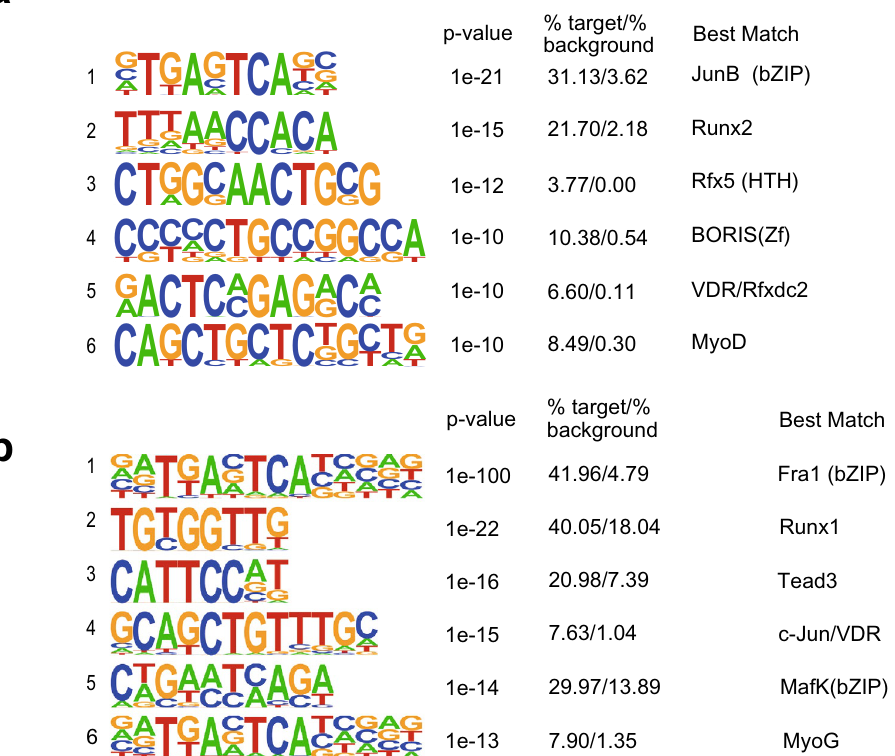
Figure 1. VDR motif is enriched in gene regions closed by simulated microgravity. ( a ) De novo motifs in the chromatin regions identified as regions closed by simulated microgravity in C2C12 myotubes. In the sequence logos, the height of each letter represents the relative frequency of the occurrence of the nucleotide at that position. ( b ) De novo motifs of the chromatin regions identified by ATAC-seq as being simulated microgravity- closed regions and as having significantly reduced H3K27Ac levels. Frequently occurring bases are represented by large letters, while infrequently occurring bases are represented by small